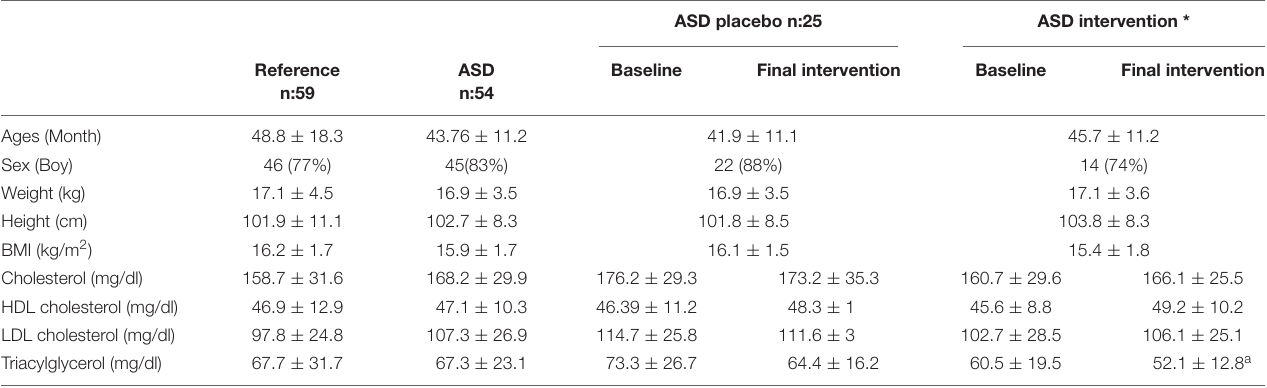
TABLE 2 | Demographic, anthropometric, and serum lipid profile in children with autism spectrum disorders (ASDs) compared with a control group and by subgroups by DHA intervention or